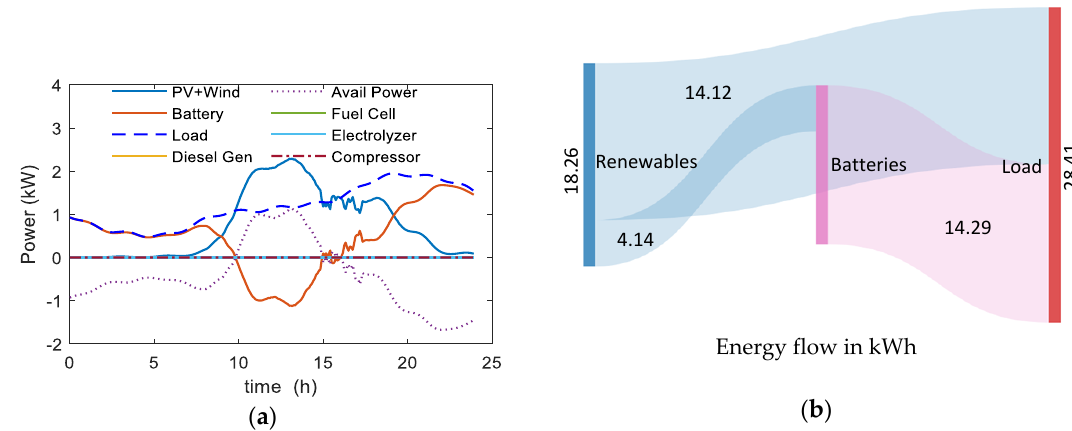
Figure 14. Node 3 at isolated operation (NMPC off) with unpredicted conditions: ( a ) Systems operation; ( b ) Energy flow (kWh).